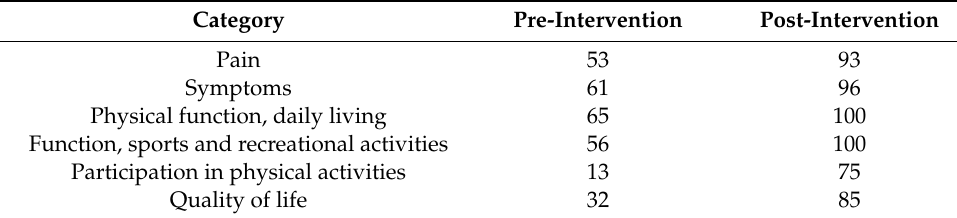
Table 1. HAGOS scores pre- and post-intervention (all scores out of 100).